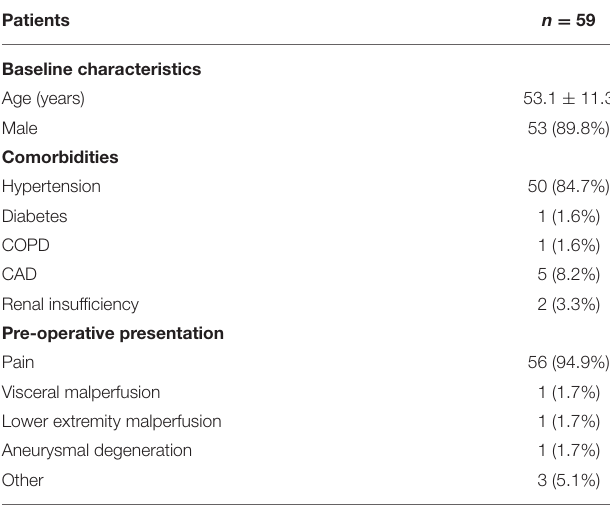
TABLE 1 | Demographic features, comorbidities, and pre-operative presentation of patients with